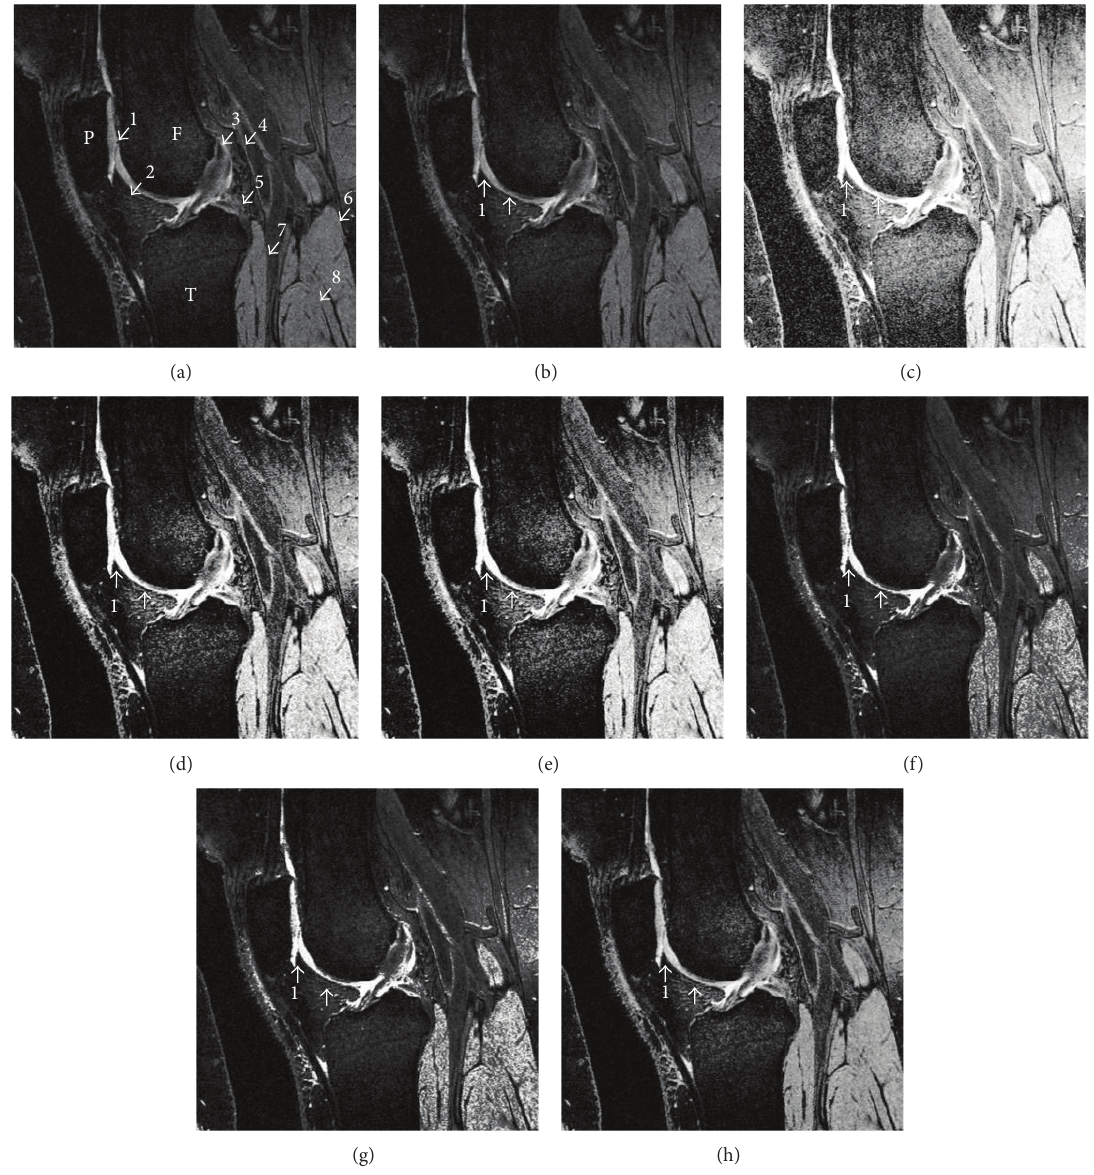
Figure 3: Central region manifestation of the left patellofemoral joint section using DESSwe MR imaging sequence. Labels in (a) indicate various skeletal elements inside knee joint (P = patellar, T = tibia, F = femur; 1 = femoral sulcus, 2 = Hoffa fat pad, 3 = anterior cruciate ligament (ACL), 4 = oblique popliteus ligament, 5 = posterior cruciate ligament (PCL), 6 = gastrocnemius muscle, 7 = popliteus muscle, 8 = soleus muscle). For comparison purpose, original MR image is remanifested in (b). Enhanced MR images using (c) THE, (d) BBHE, (e) DSIHE, (f) RMSHE, (g) RSIHE, and (h) BBCCE show the contrast enhancement effect relative to (b). The femoral sulcus (white arrow labeled as “1”) and intensity variation within cartilage (unlabeled white arrow) are indicated in images from (b) to (h).